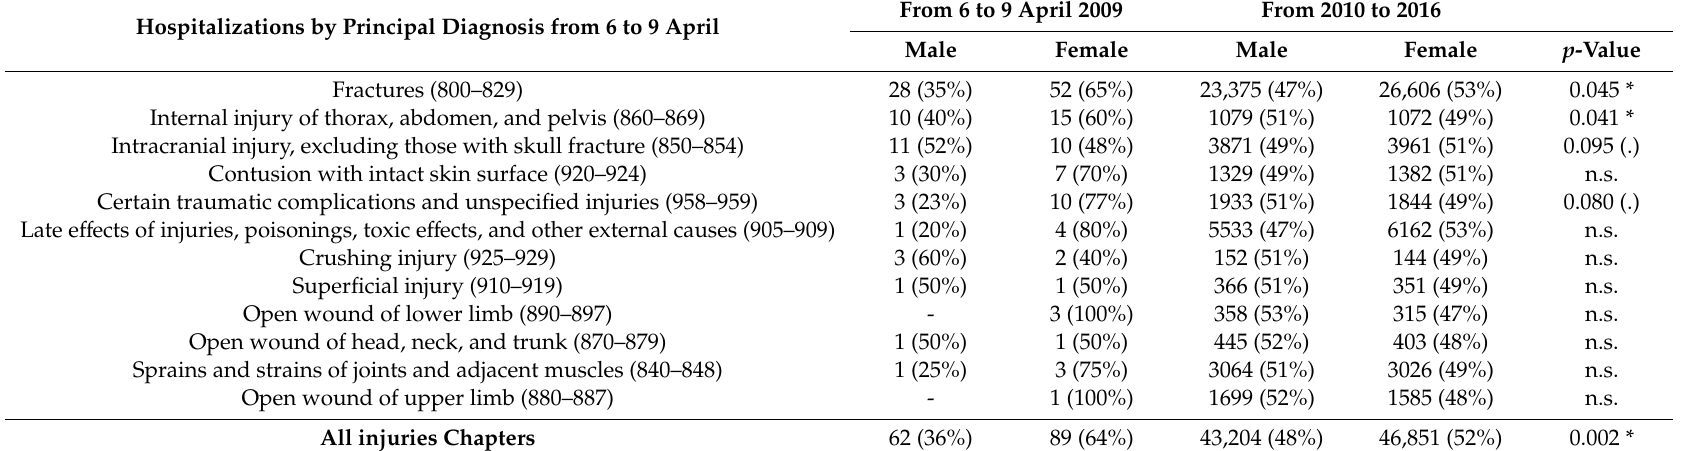
Table 3. Frequencies sorted by sex among the population in the seismic crater and the overall Abruzzo population admitted to hospital due to an injury in 2009 vs. 2012–2016. (ICD-9-CM, Injury